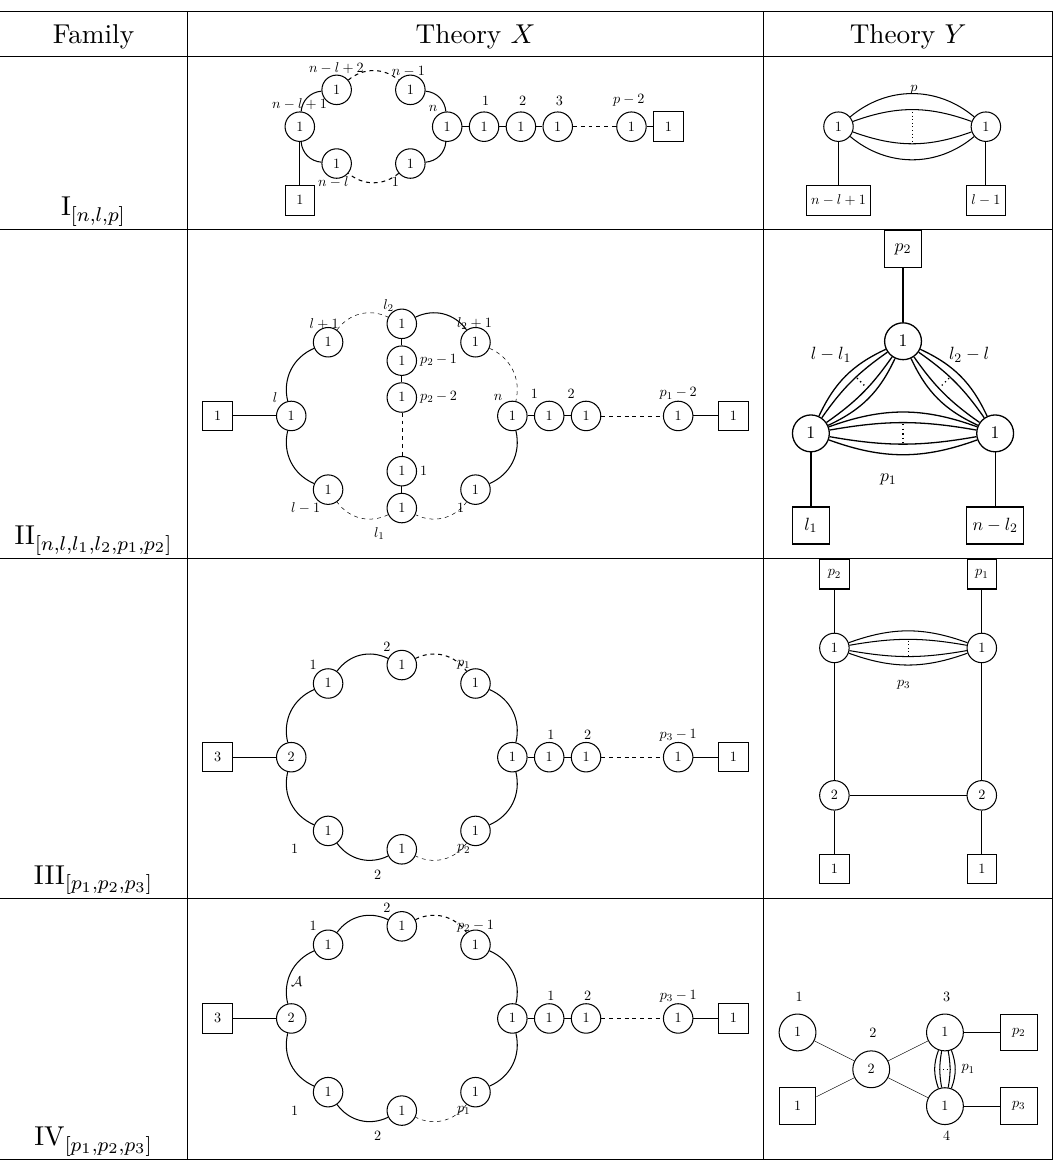
Table 1 . Summary table of non- ADE families of quiver gauge theories which are mirror dual to each other. The 3d N = 4 quiver notation, used throughout this paper, is explained in figure 2. In particular, the line labelled A in quiver X of Family IV denotes a hypermultiplet which transforms in the rank-2 antisymmetric representation of the U(2) gauge group (i.e. has charge 2 under the U(1) ⊂ U(2) and is a singlet under the SU(2) ) and has charge 1 under the U(1)